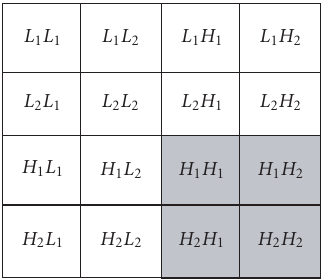
Figure 3: Subbands corresponding to a single-level multiwavelet decomposition.